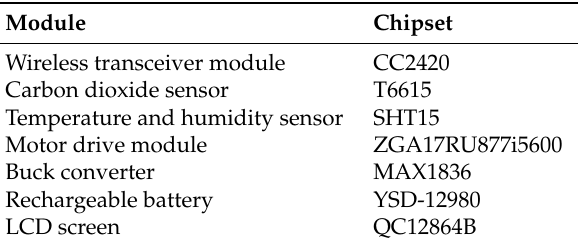
Figure 5. Block diagram of control circuit of SCFSen . Table 1. Chipsets adopted in SCFSen